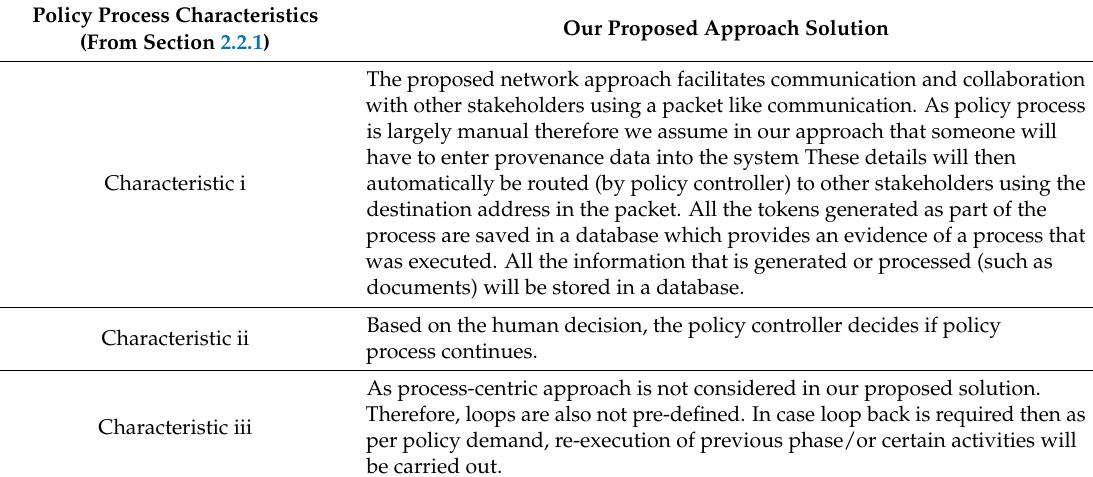
Table 3. Effectiveness of the network-based approach—handling policy process characteristics. Policy Process Characteristics (From Section